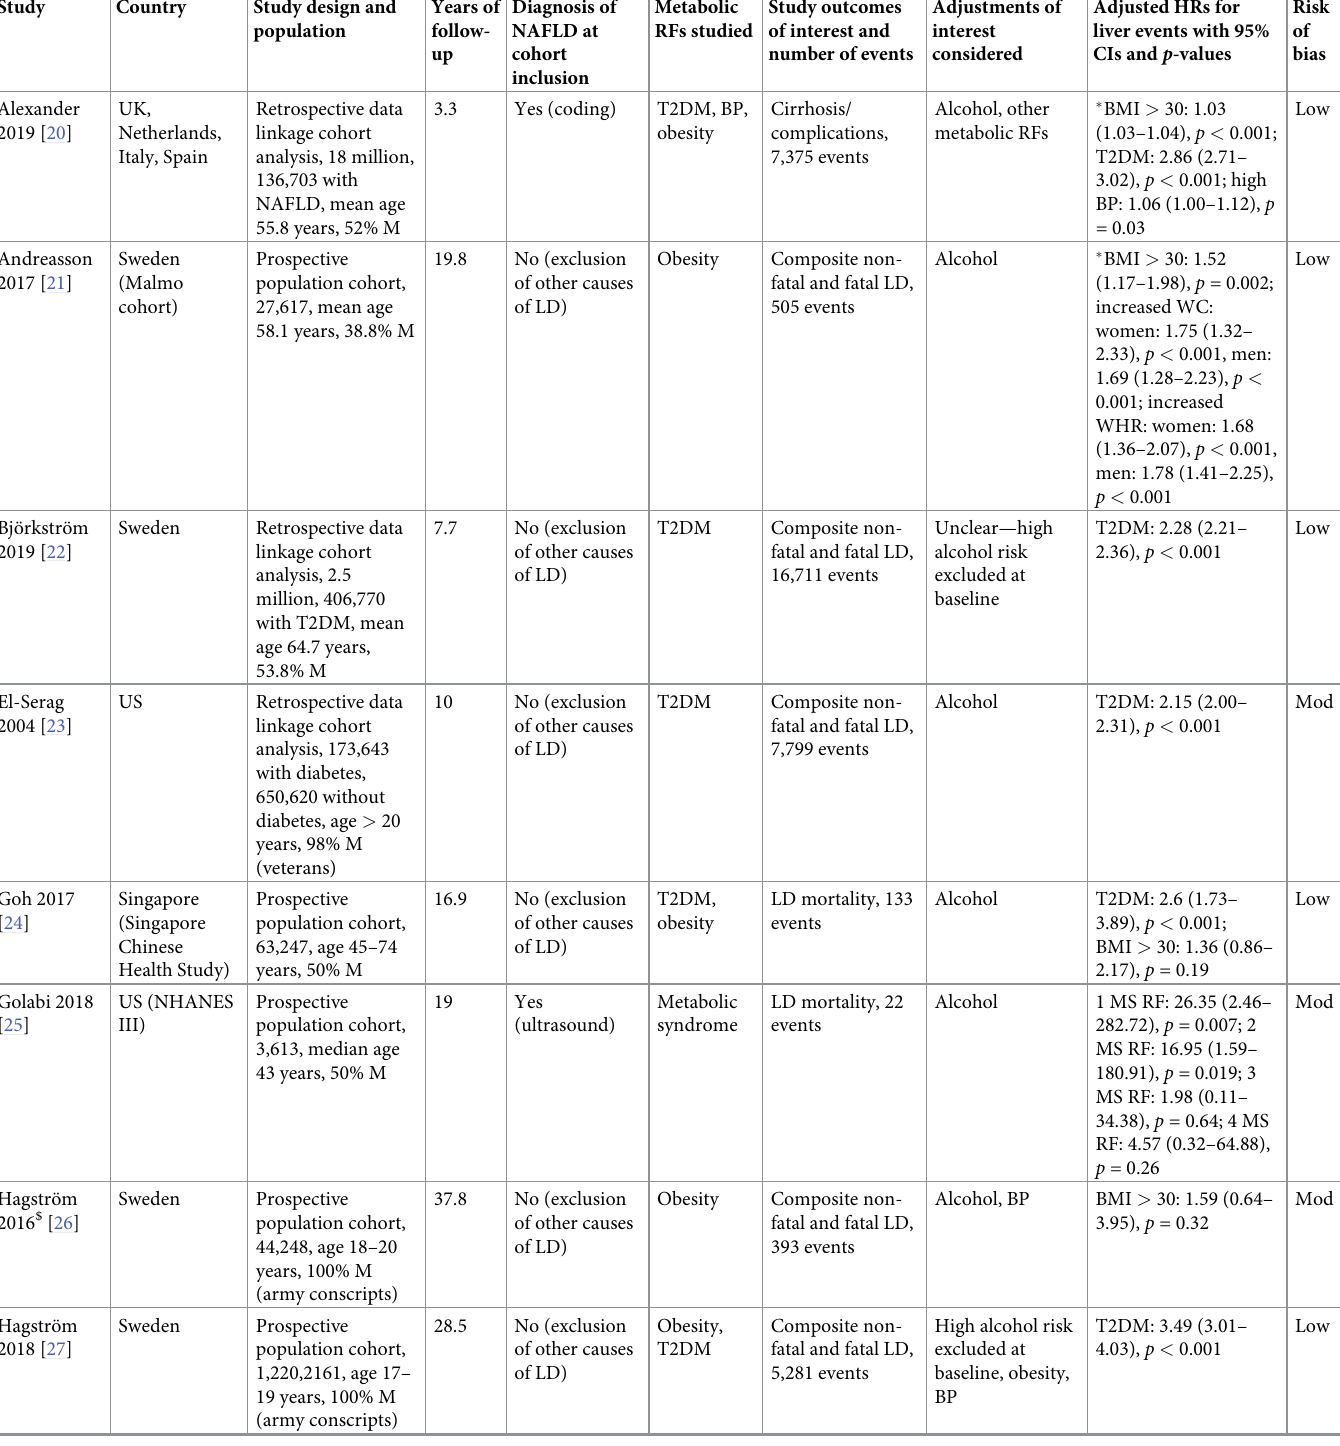
Table 1. Characteristics of included